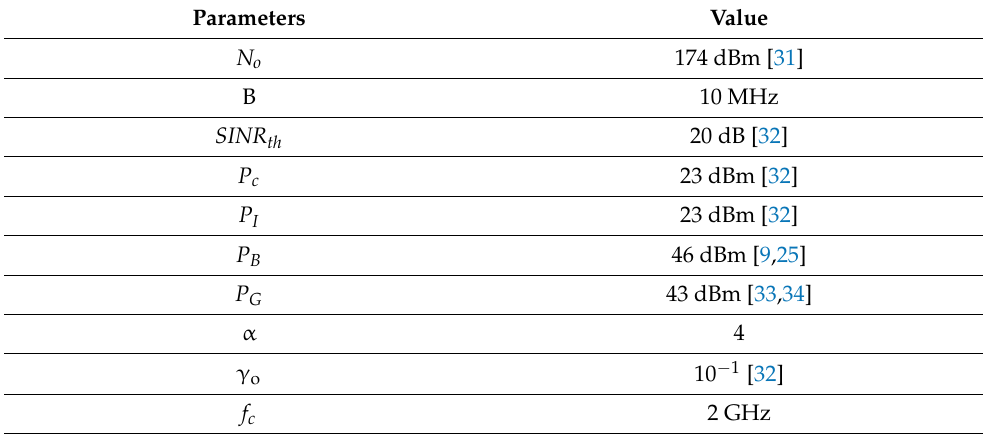
Table 1. Simulation Parameters.